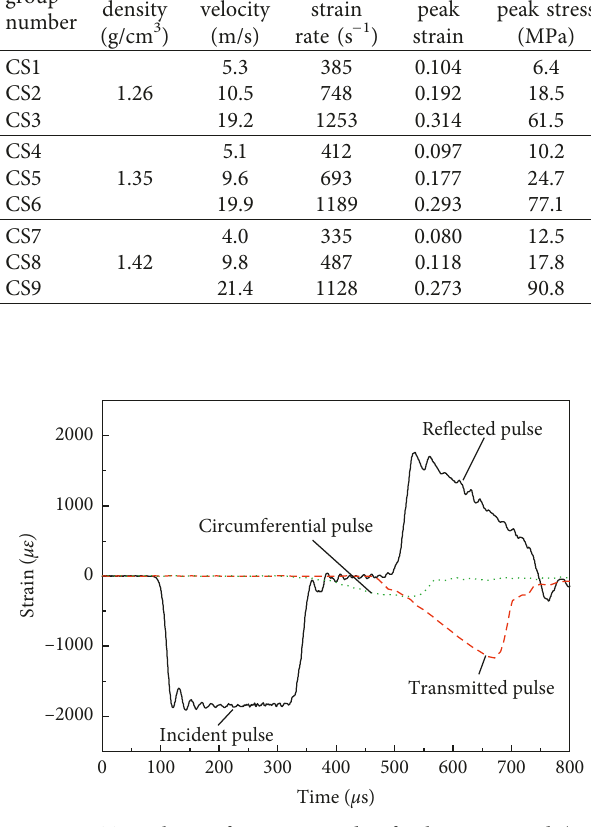
Figure 5: Typical set of strain records of calcareous sand (test group number: CS9).